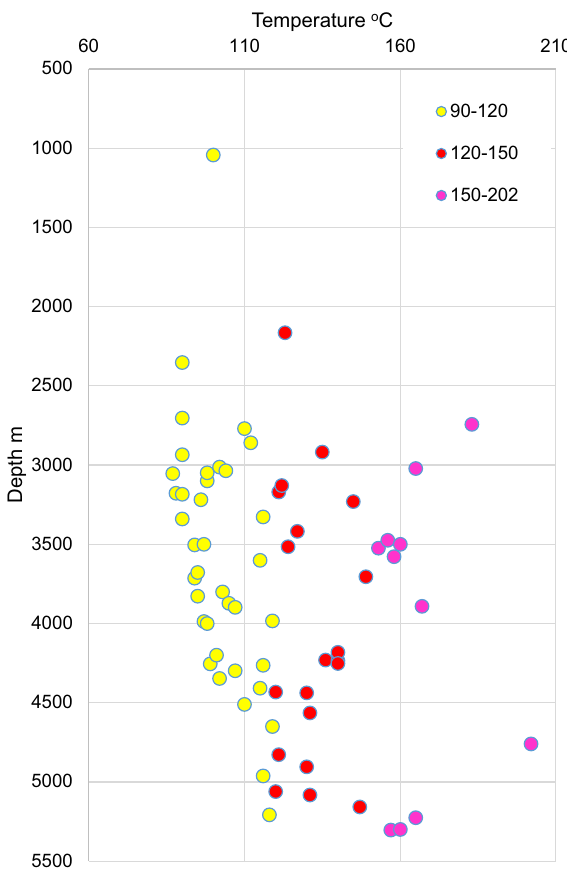
Fig. 10 Depth vs maximum temperatures recorded in oil drilling in Spain (IGME